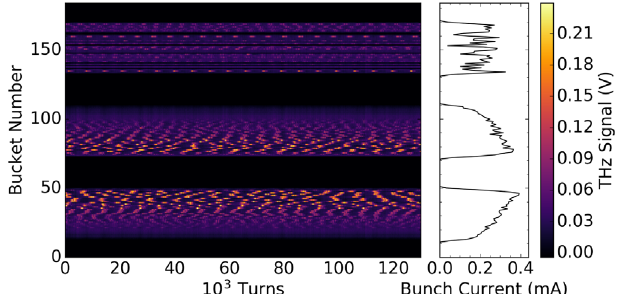
FIG. 1. The fluctuating THz signal (color coded) of each of the 184 rf-buckets is shown for the first 130 thousand consecutive turns, out of the total recorded of 2.7 million in one second. The bursting behavior differs for bunches with different currents. On the right-hand side the filling pattern, consisting of three trains, is indicated by the bunch current (adapted from [22]).